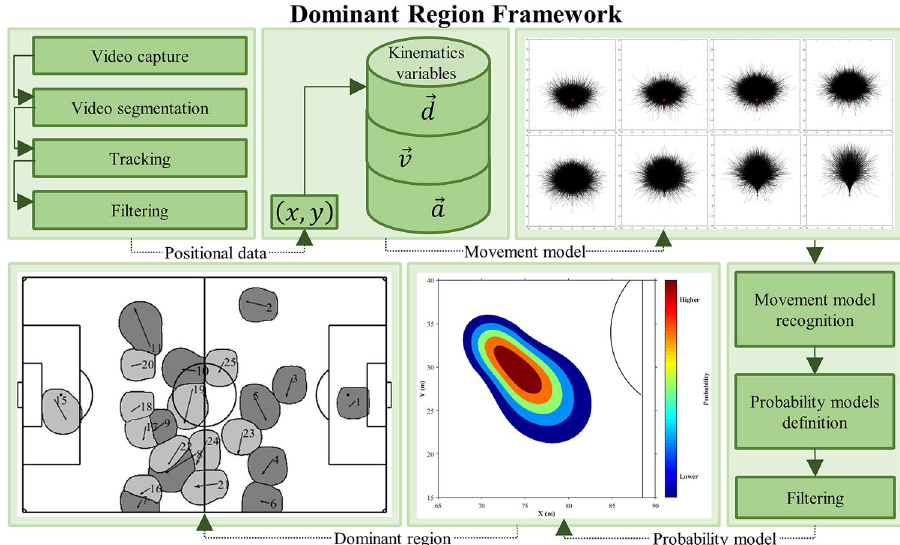
Figure 1. Representation of dominant region framework of our approach, from positional data collection, movement models creation, probability models definition, until to players dominant region